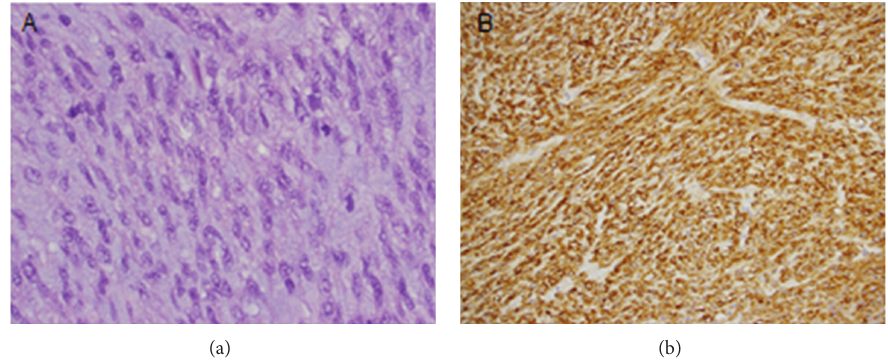
Figure 4: (a) Photomicrograph of the resected specimen stained with H + E showing features of high grade GIST with mitotically active spindle and epithelioid cells involving the gastric and perigastric adipose tissue (60x magnification). (b) IHC staining demonstrating strong diffuse staining for CD117 (20x